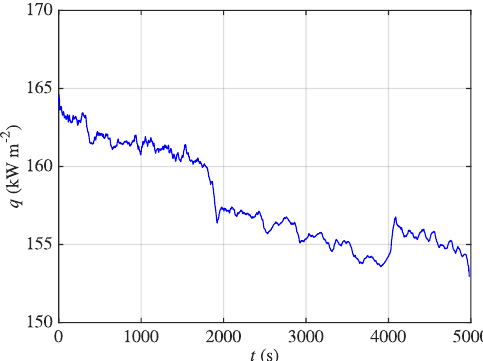
Figure 11. The dynamic method—course of heat flux.